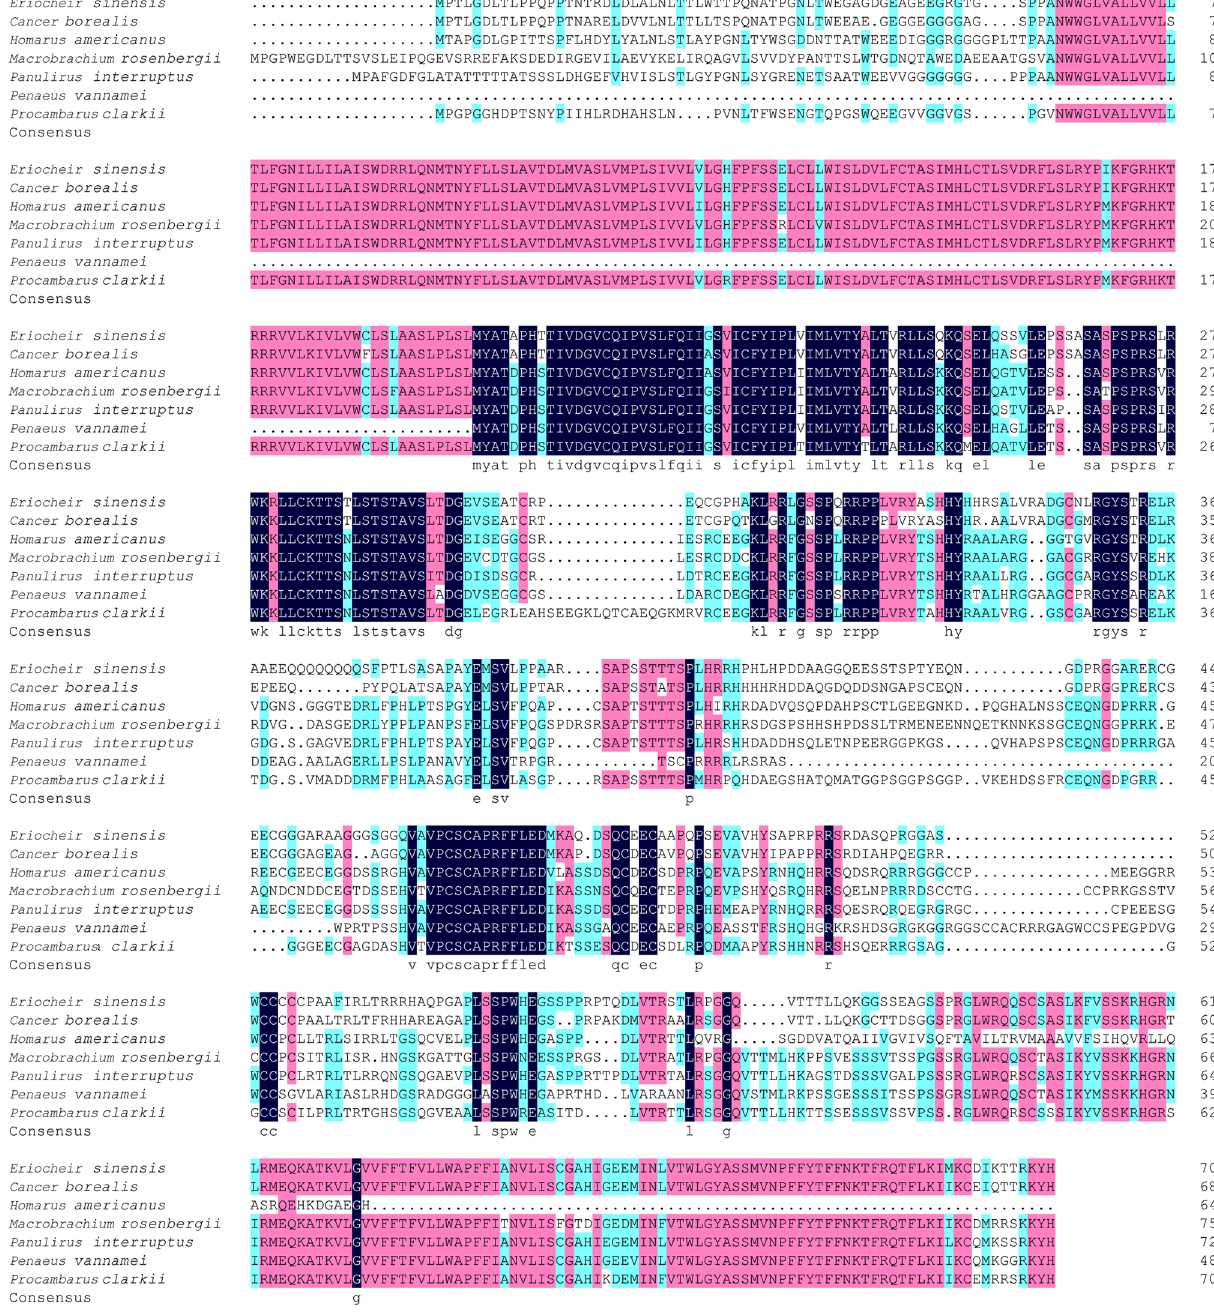
Figure 2. Alignment of the E. sinensis 5-HT2B gene amino acid sequence with those of other crustaceans. Conserved residues are highlighted in black. The 5-HT2B gene sequences of C. borealis